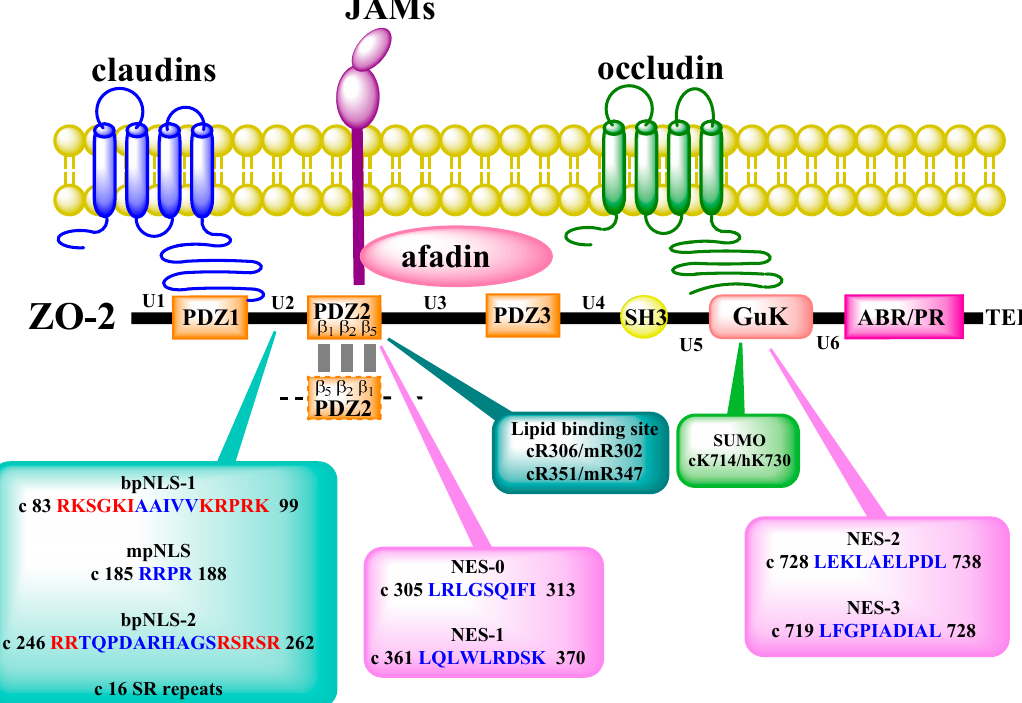
Figure 1. ZO-2 molecular organization and interactions with integral tight junction (TJ) proteins at the plasma membrane. ZO-2 domains (PDZ, SH3, and GuK), regions (U, unique; ABR, actin binding; PR, proline rich), and PDZ-binding motif (TEL) are indicated, as well as the nuclear localization signals (NLS) and exportation signals (NES), SUMOylation (SUMO) and lipid binding sites, and dimerization region. The ZO-2 sequence is identified by letters: c, canine; m, mouse; h, human. Numbers correspond to amino acids. Clusters of basic amino acids (K/R) in the bpNLS are shown in red. bp, bipartite; mp, monopartite.